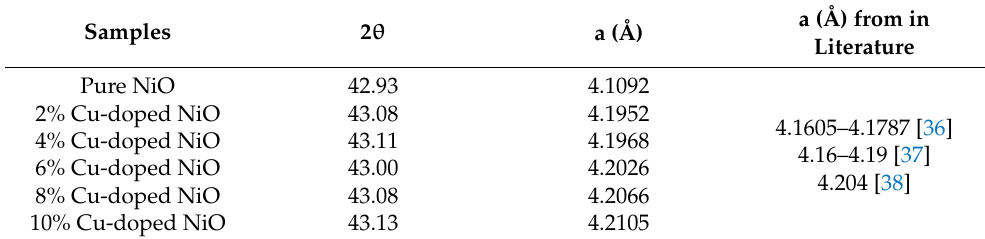
Table 1. Estimation of lattice parameter.